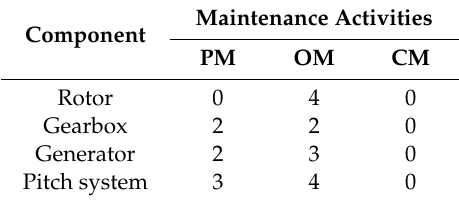
Table 9. Summary of different types of maintenance activities.